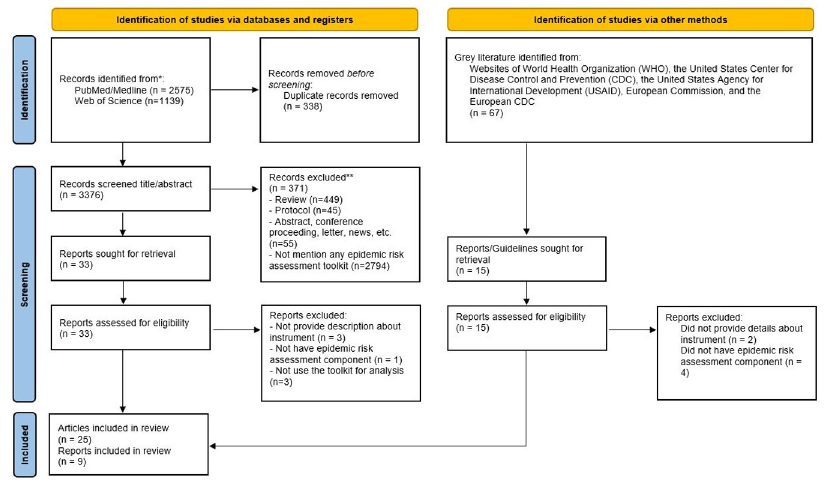
Fig 1. Results of the searching